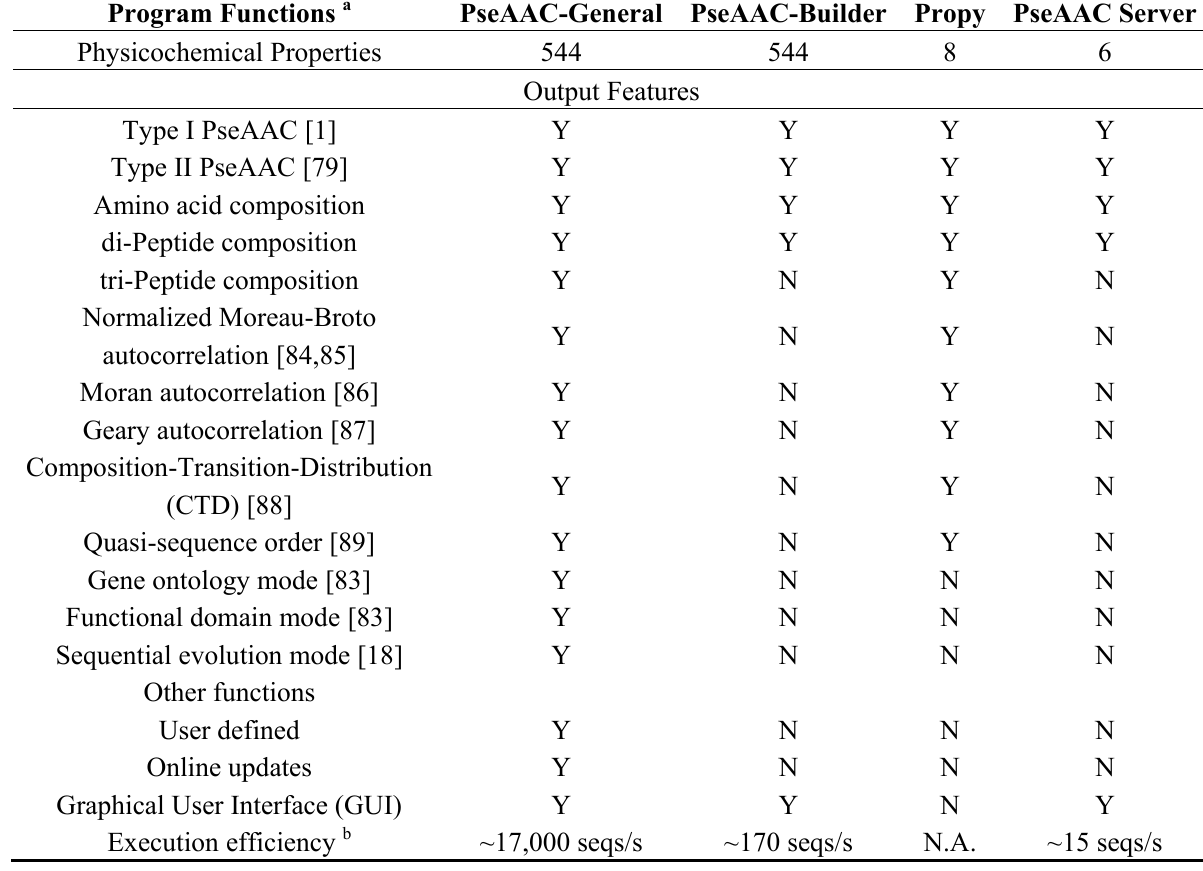
Table 1. Comparison of program